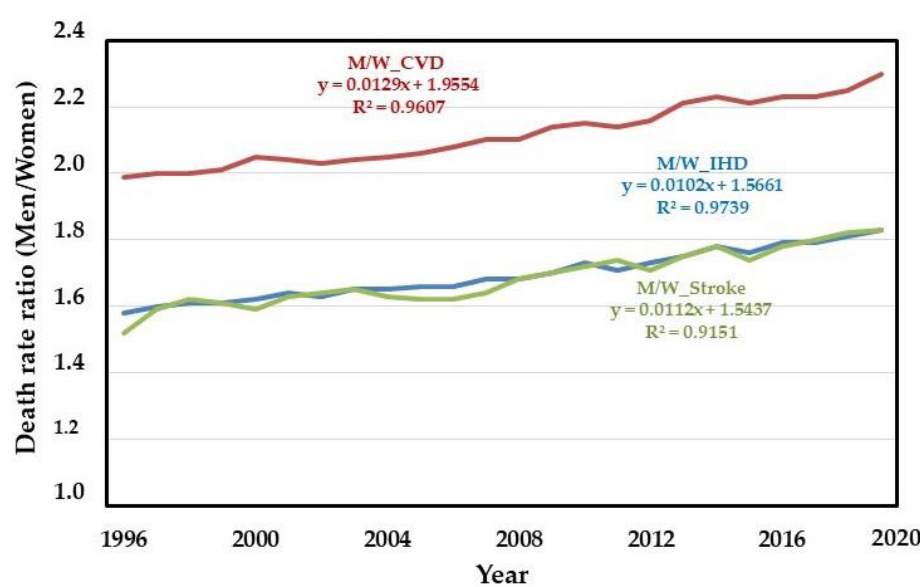
Figure 3. Regression lines of the ratio of men and women death rates per 100,000 population, and regression data, for cardiovascular disease (CVD), ischemic heart disease (IHD), and stroke in women (W) and men (M) from 1996 to 2019. Crude death rates per 100,000 inhabitants for five-year age groups between 35 and 74 years, the percentage change in rates (1996–2019), and AAPC for ACD, CVD, IHD, and stroke, in the whole population, in men and women, are shown in Tables 3 and 4. Table 3. The crude death rate, the percentage change between 1996 and 2019, mean annual percentage change (AAPC), and 99% confidence limits (99%CL) for all causes of death and cardiovascular diseases per 100,000 population.